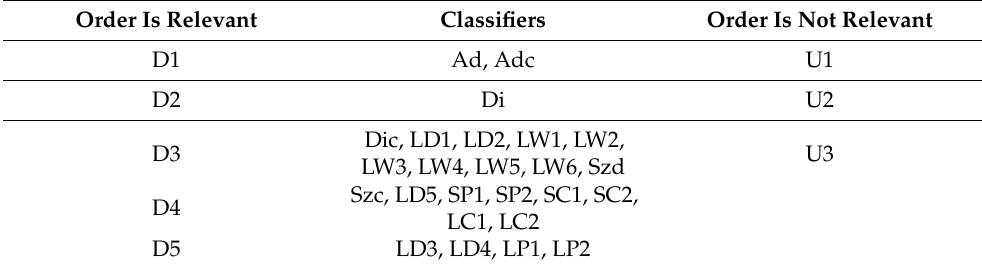
Table 12. Different partitions of vertices for C 28 − T d